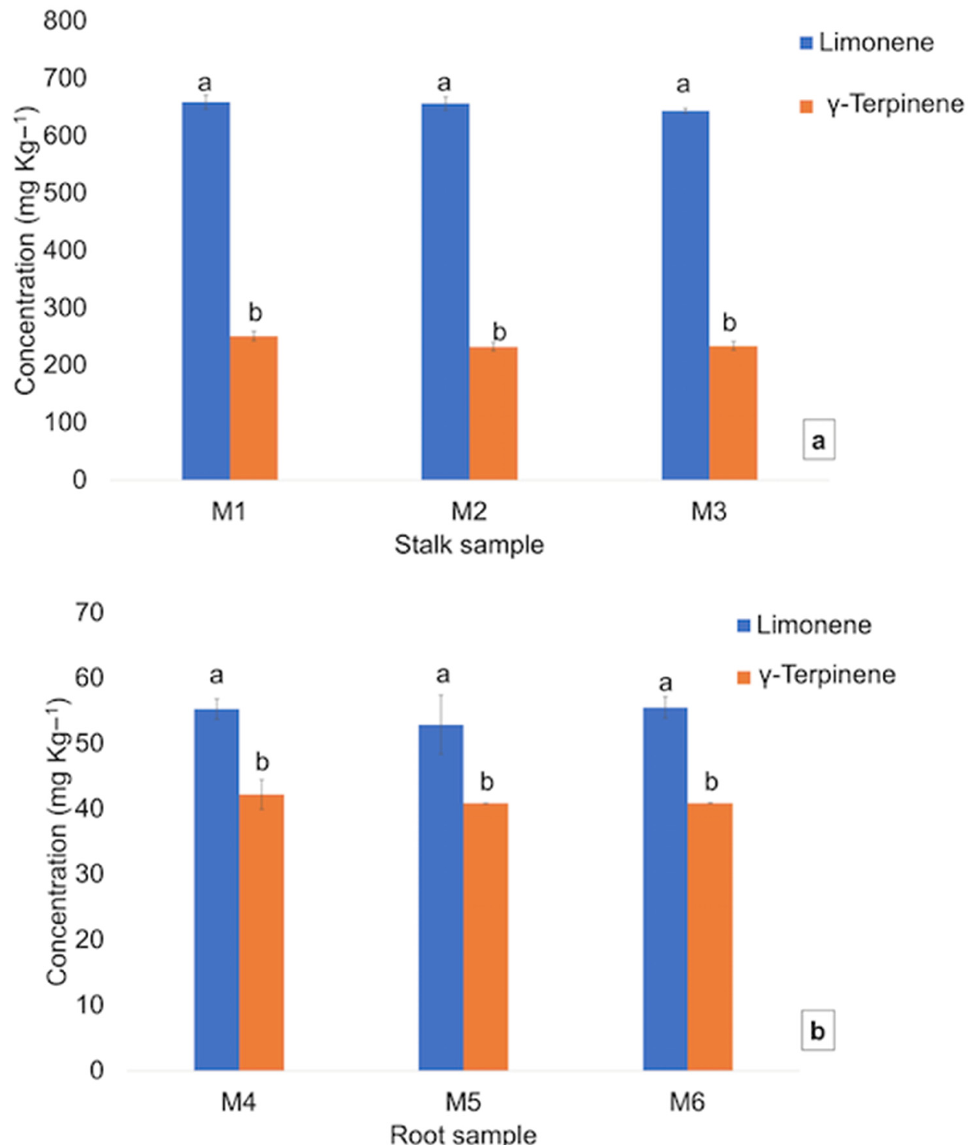
Figure 7. Volatile concentration (mg Kg − 1 ) of limonene and γ -terpinene in celery stalk ( a ) and root ( b ) samples. Values ( n = 3 ± SD) followed by the same letter, within the same volatile compound, were not significantly different ( p < 0.05), according to Tukey’s least significant difference test.